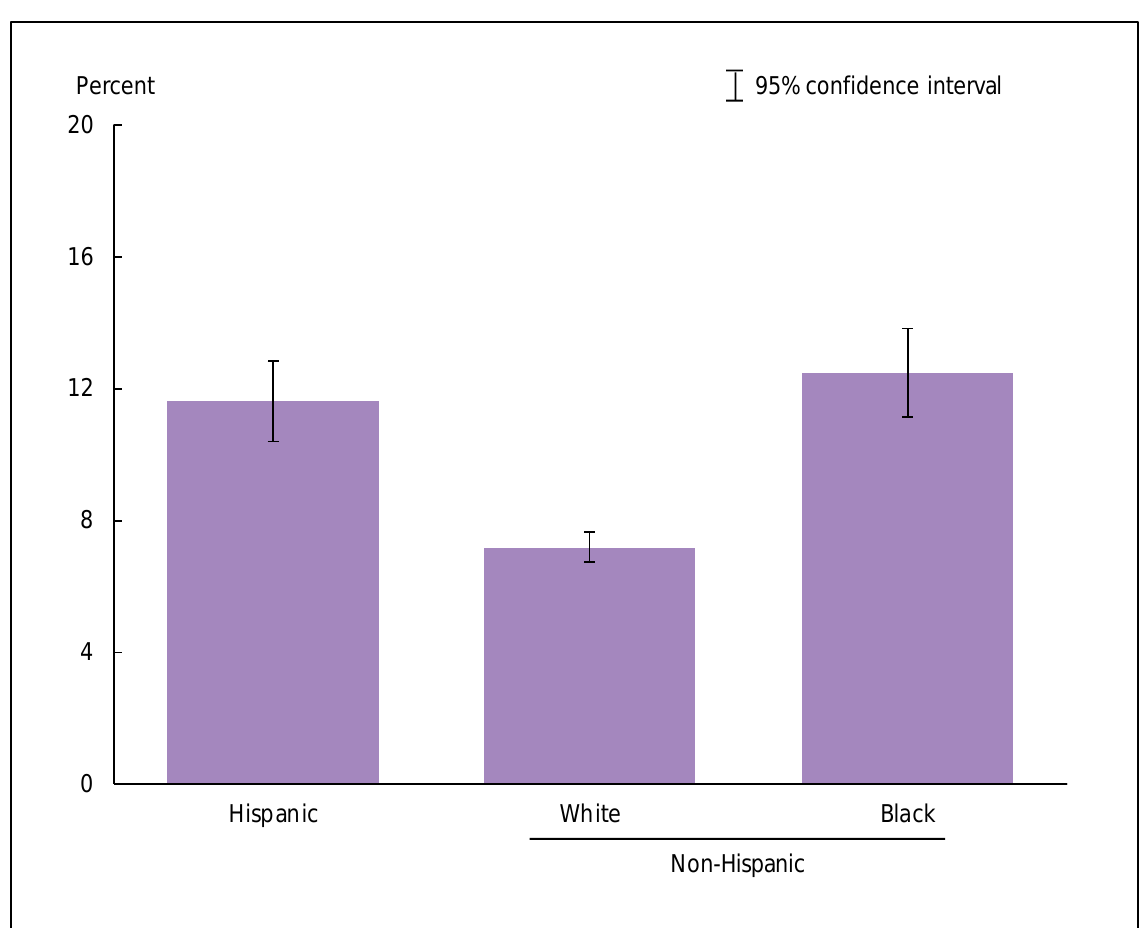
Figure 14.3. Age-sex-adjusted prevalence of diagnosed diabetes among adults aged 18 and over, by race and ethnicity: United States,